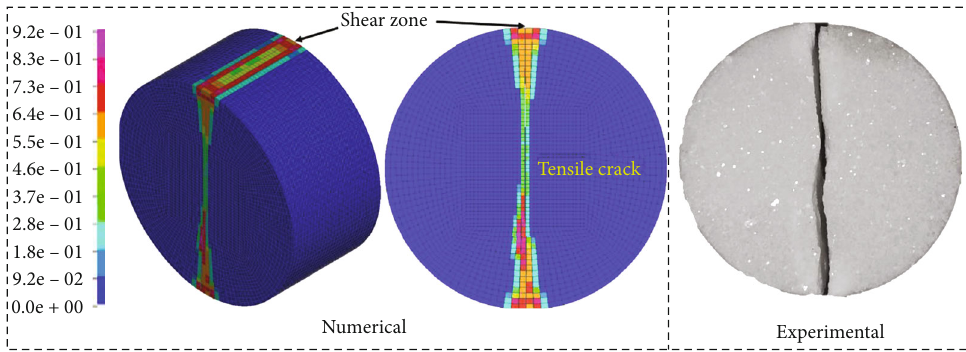
Figure 9: Comparison of fracturing mode between experiment and simulation (plastic